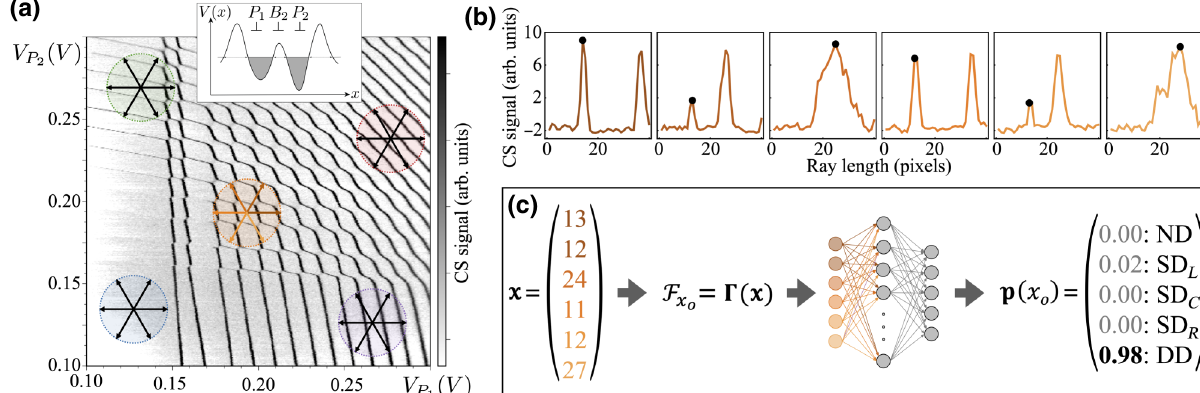
FIG. 1. Visualization of the ray-based fingerprinting framework. (a) A preview of five points in the space of plunger gates ( P 1 , P 2 ) with six evenly distributed rays overlaying a sample measurement. Different colors represent different QD states. The inset shows the and V P control the occupation of each QD. Gate voltage V B potential landscape of the double-quantum-dot system. Gate voltages V P 1 2 controls the inter-QD tunneling. (b) The preprocessed charge sensor (CS) signal for six evenly distributed rays measured from a point ) = ( 0.193, 0.193 ) V [the most central point in (a)] as a function of ray length. The length resolution is 0.5 mV per pixel. ( V P 1 , V P 2 ) ≡ x , V P In each ray, the position of the transition line nearest to the point ( V P o —that is, the critical feature along a given ray—is 1 2 marked with a dot. (c) The flow of the RBC framework adapted from Ref. [29]. A vector of critical features x is processed using a is processed by a DNN classifier, returning a probability vector p ( x o ) quantifying weight function (cid:2)( x ) . The resulting fingerprint F x o the current state of the device at point x o